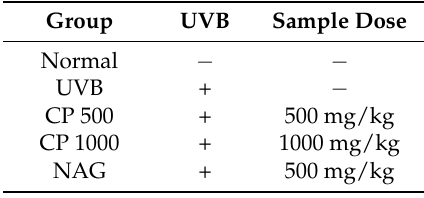
Table 1. Description of the experimental